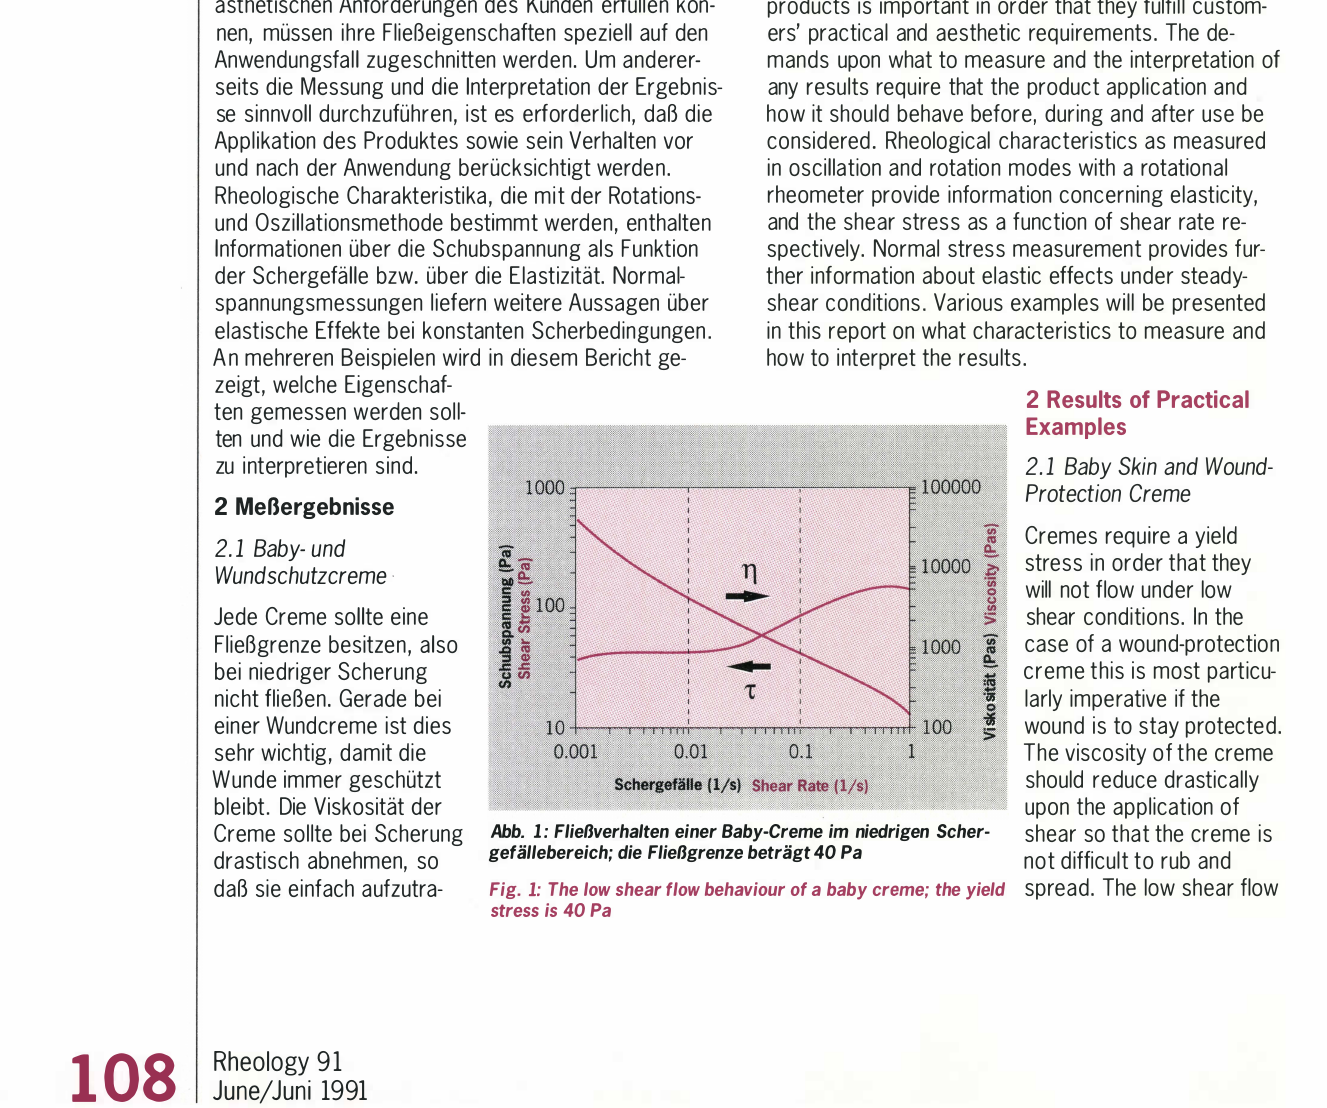
Fig. l: The low shear flow behaviour of a baby creme; the yield stress is 40